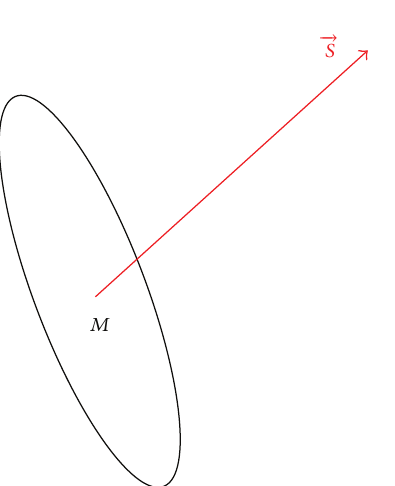
Figure 3: A disc plane that represents discontinuity in 3D space.